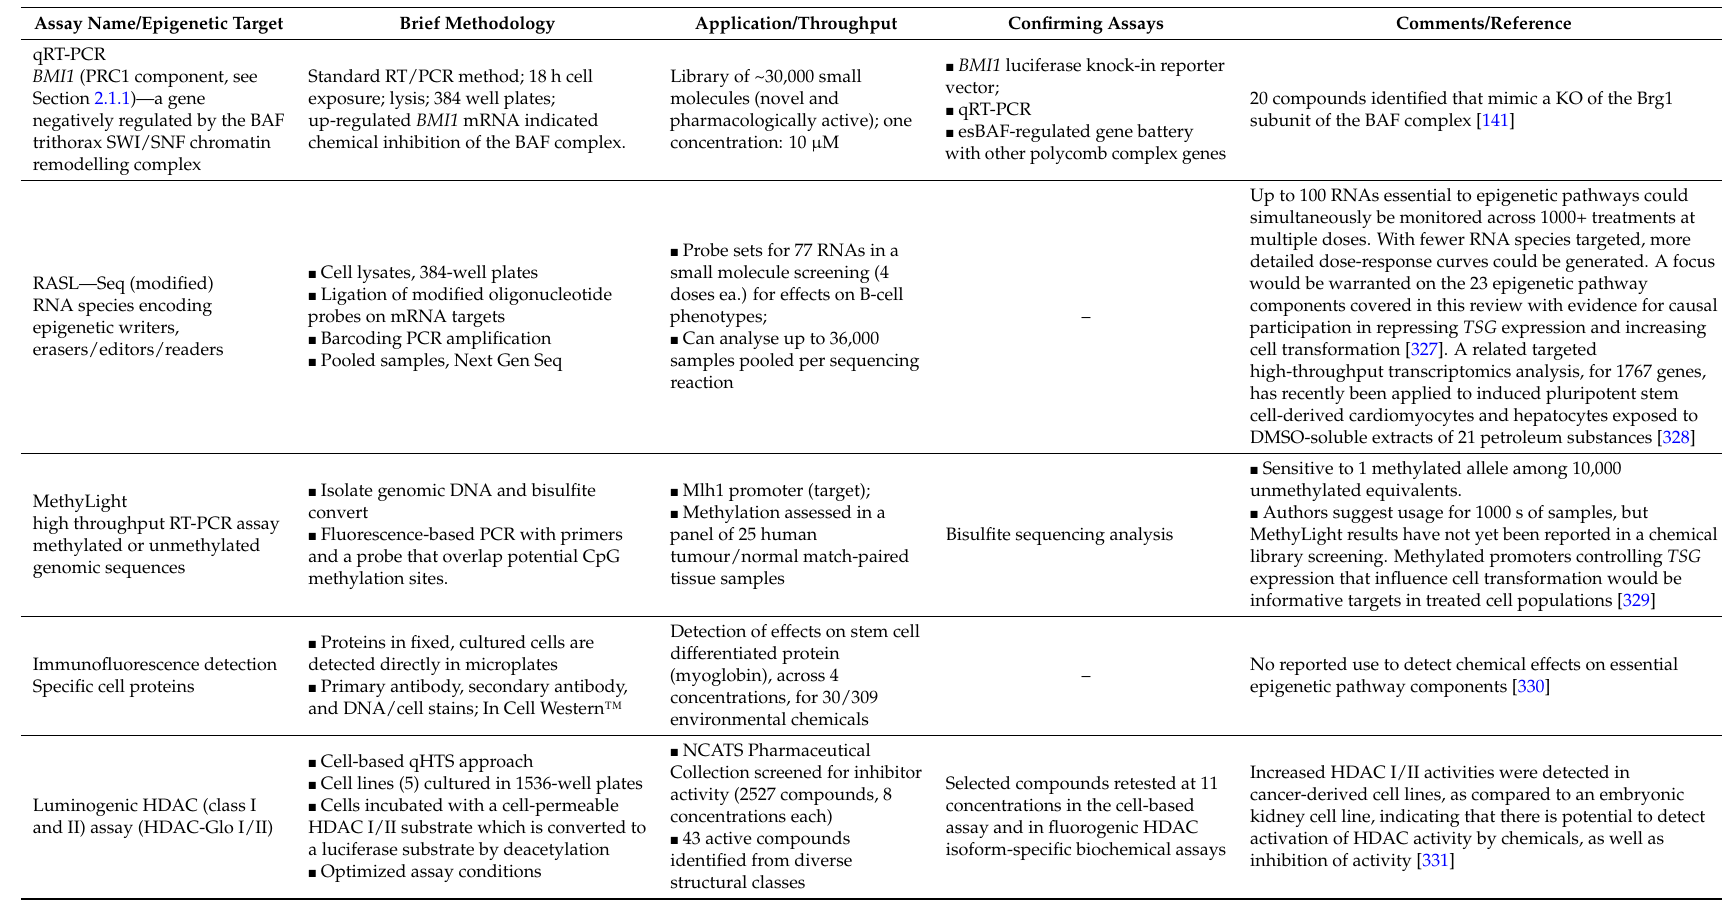
Table 6. In vitro cell screening assays with cell-average readouts for effects on epigenetic pathway